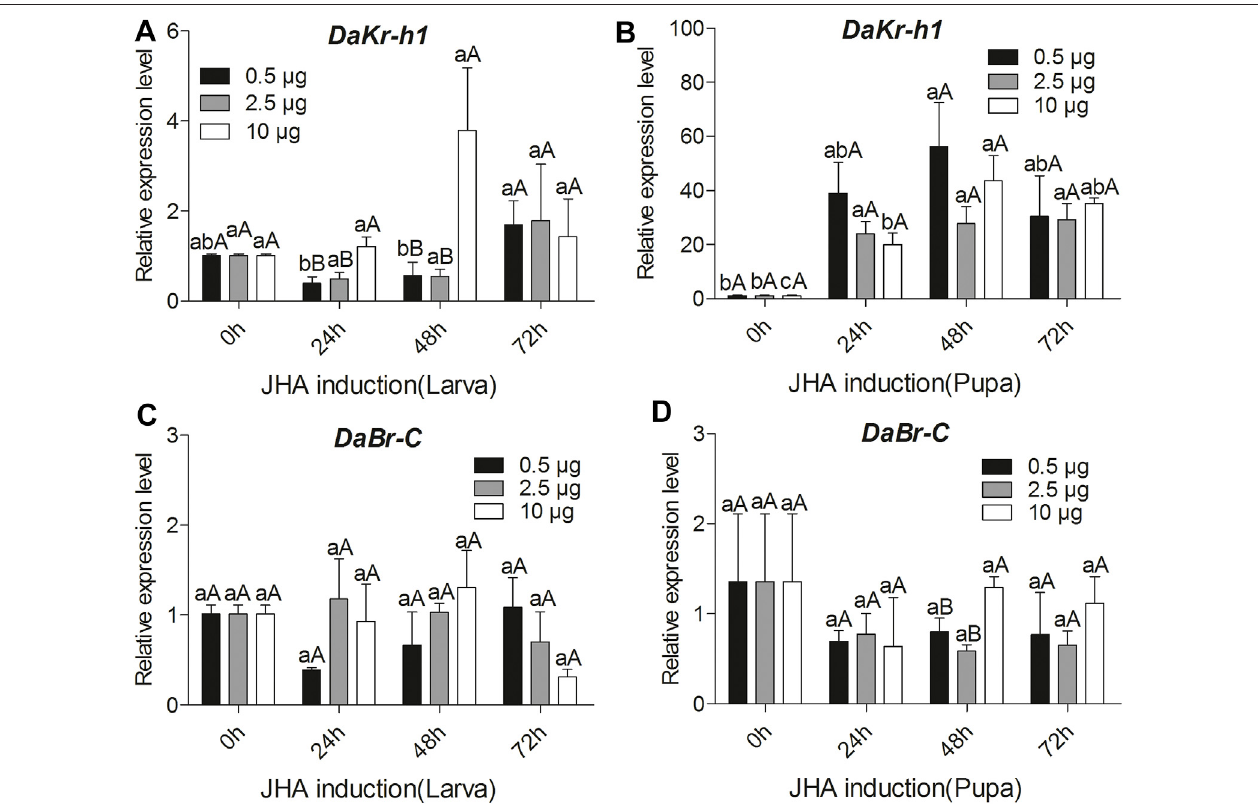
FIGURE4| Quantitativeexpressionsof DaKr-h1 and DaBr-C geneswithJHA(0.5,2.5,10 μ g)atdifferentlarvalandpupalstages.Transcriptlevelsof (A) DaKr-h1 in larvae, (B) DaKr-h1 in pupae, (C) DaBr-C in larvae, and (D) DaBr-C in pupae. Data are means ± SE of three independent experiments. In all graphs, transcript levels are shown relativetoacetone-treatedlarvaeand pupae (control).Alltemplates werenormalizedwith CYP4G55 and β -actin .The2 − ΔΔ Ct and SEvalueswereusedforplotting the graphs. Different letters indicate signi fi cant differences at p < 0.05 (two-way ANOVA). Uppercase letters indicate signi fi cant differences of concentration at the same time, whereas lowercase letters indicate signi fi cant differences of time at the same concentration.